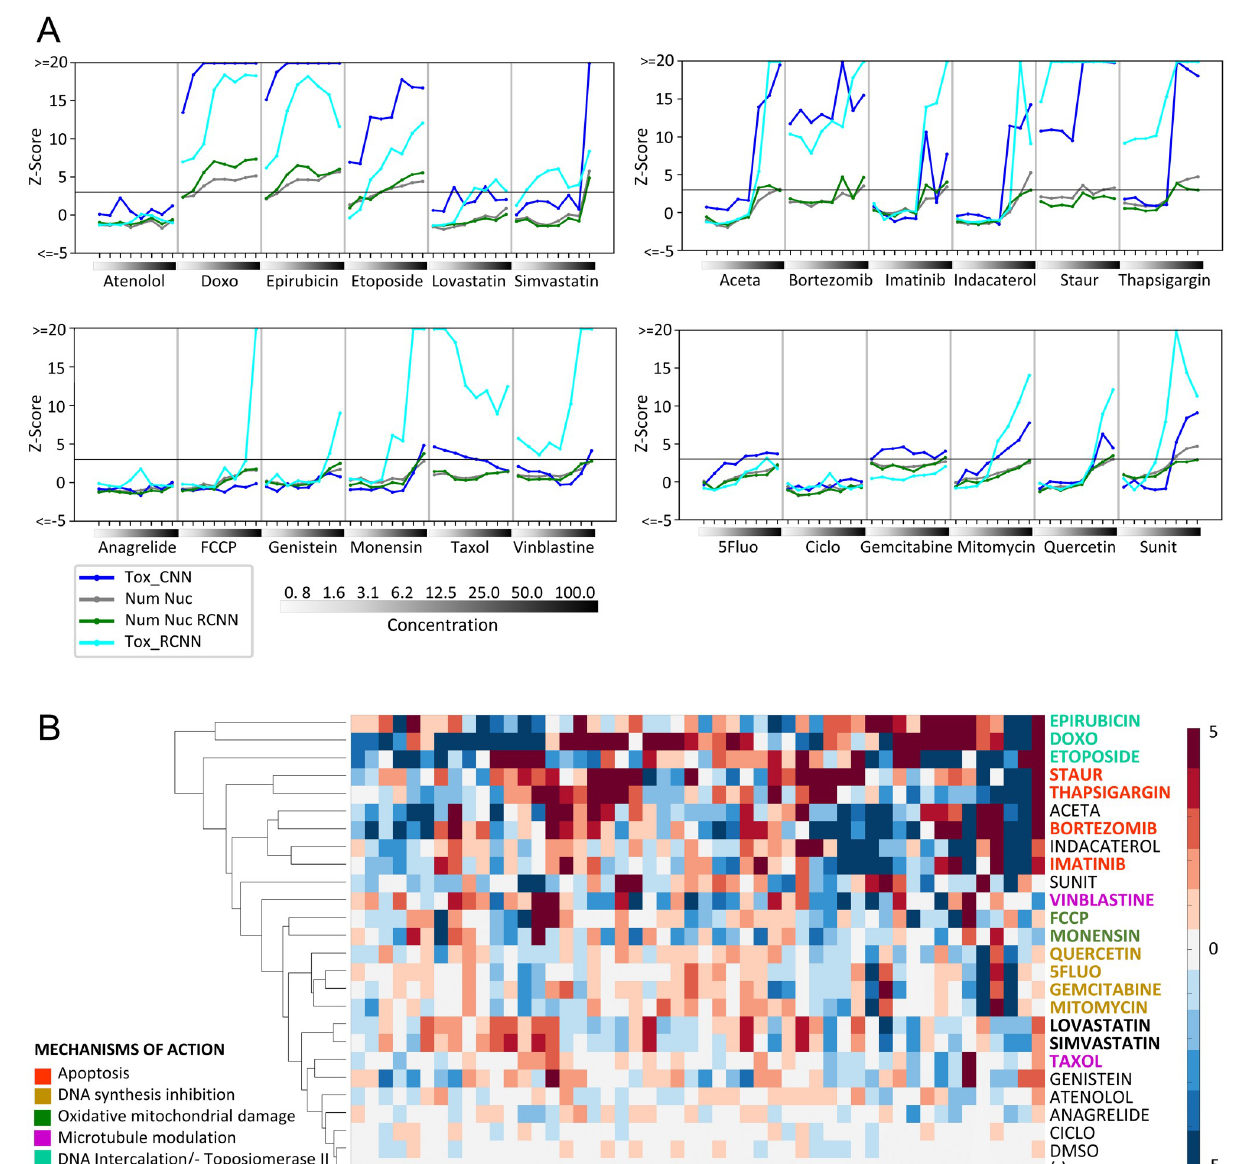
Fig 4. Deep (R)CNN model validation to predict toxicity and to extract knowledge for clustering of drugs based on their toxicity mechanisms. HL1 cells treated with one of 24 compounds or DMSO at the concentrations indicated ( μ M) (Experiments #11–14) were processed as described in the Materials and Methods. (A) Plots displaying mean toxicity readouts of four replicate wells, obtained from percentage of healthy cells predicted by the CNN Nuc (Tox_CNN) or RCNN (Tox_RCNN) mixed models, and from nuclei counting by standard image segmentation (Num Nuc), or by using RCNN-based automated detection (Num Nuc RCNN). For each well, toxicity readouts were obtained by computing Z-scores (normalizing to DMSO- treated wells) with adjustment of the sign to display toxic effects as positive values. (B) Hierarchical clustering of features obtained with the Tox_CNN model from HL1 cells treated with 25 μ M of the indicated drugs or 0.78 μ M Taxol; untreated (-); DMSO, control. Colors highlight mechanism of toxicity associated with